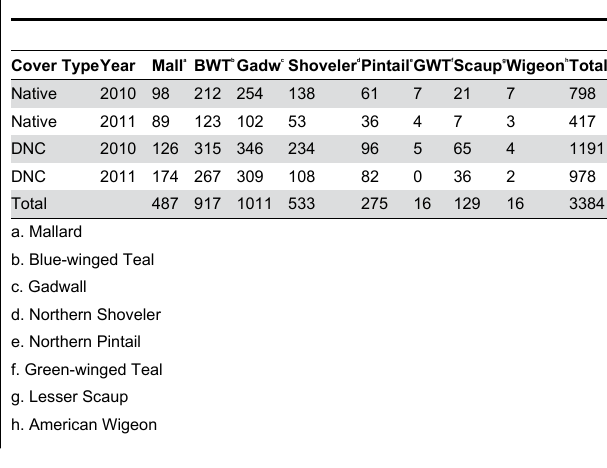
Table 3. Total number of nests broken down by cover type and species in 2010-11 in the Devils Lake Wetland Management District, North Dakota.